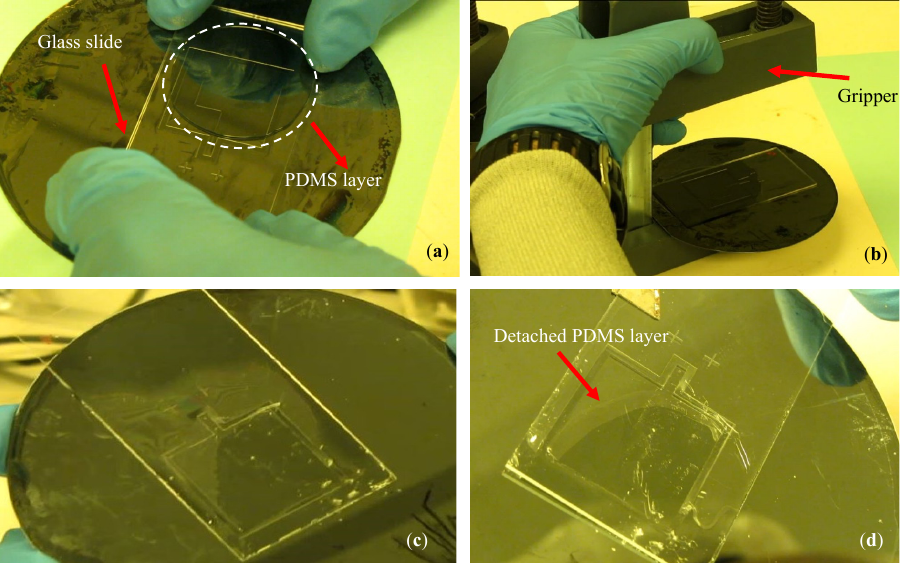
Figure 5. The PDMS layers fabrication processes: ( a ) pouring PDMS on the mold; ( b ) applying pressure using grippers; ( c ) PDMS layer after curing process; ( d ) detaching PDMS layer from the mold.